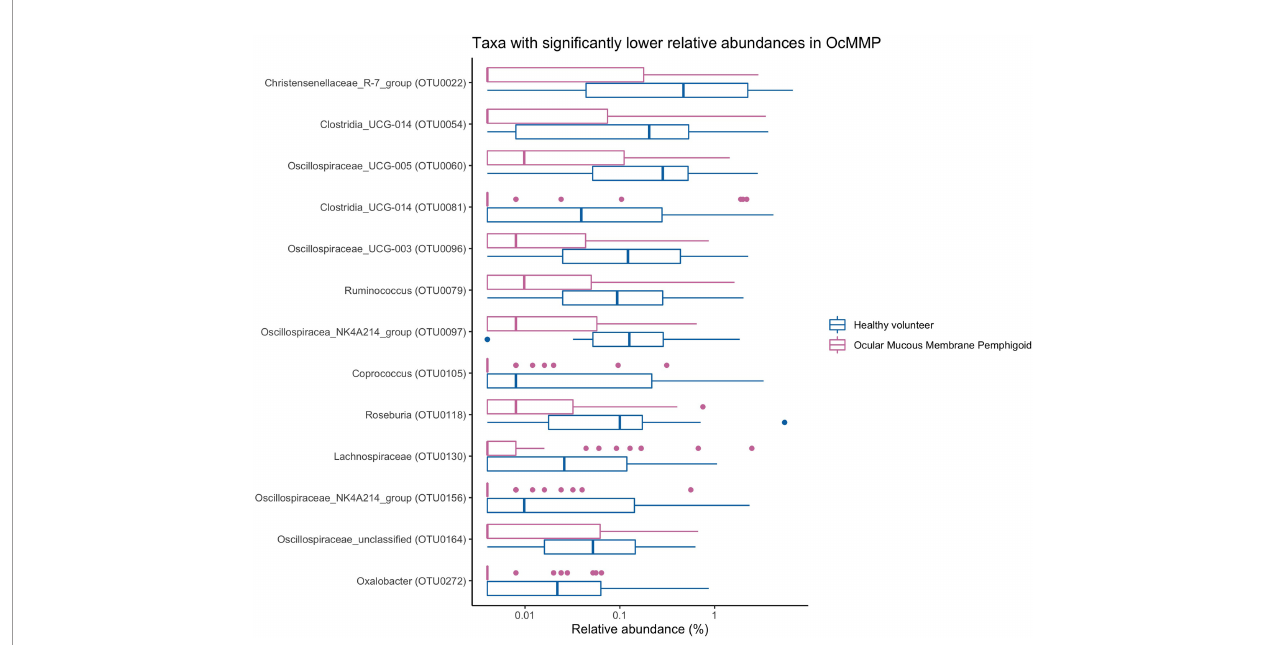
FIGURE 5 | Comparisons of the abundances of bacterial taxa that are signi fi cantly enriched in healthy volunteers. Oxalobacter, Clostridia uncultured genus-level group (UCG) 014, Christensenellaceae R-7 group and butyrate-producing bacteria such as Ruminococcus, Lachnospiraceae, Coprococcus, Roseburia, Clostridia uncultured genus-level group (UCG)-014, Oscillospiraceae UCG-003, 005, NK4A214 group were enriched in healthy